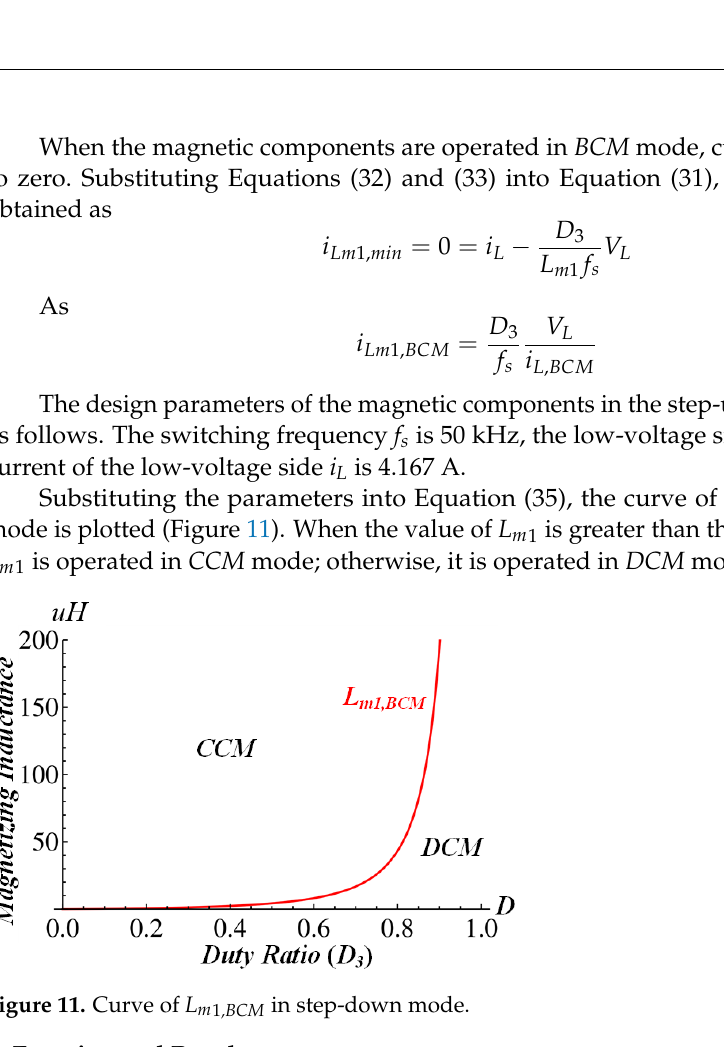
Table 1. Electrical specifications and component parameters of the proposed converter.